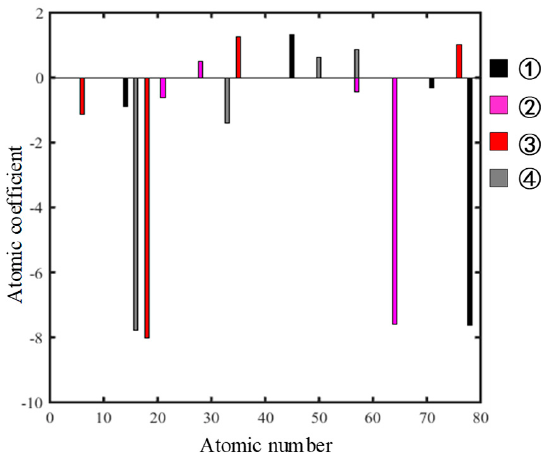
Figure 9. The dictionary atom and sparse coefficients used.